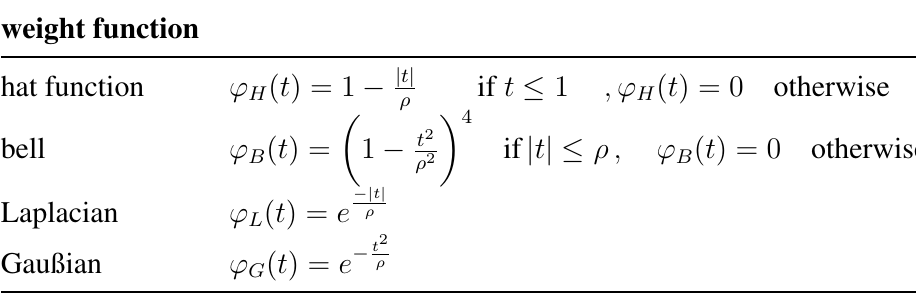
Table 1. Examples of weight